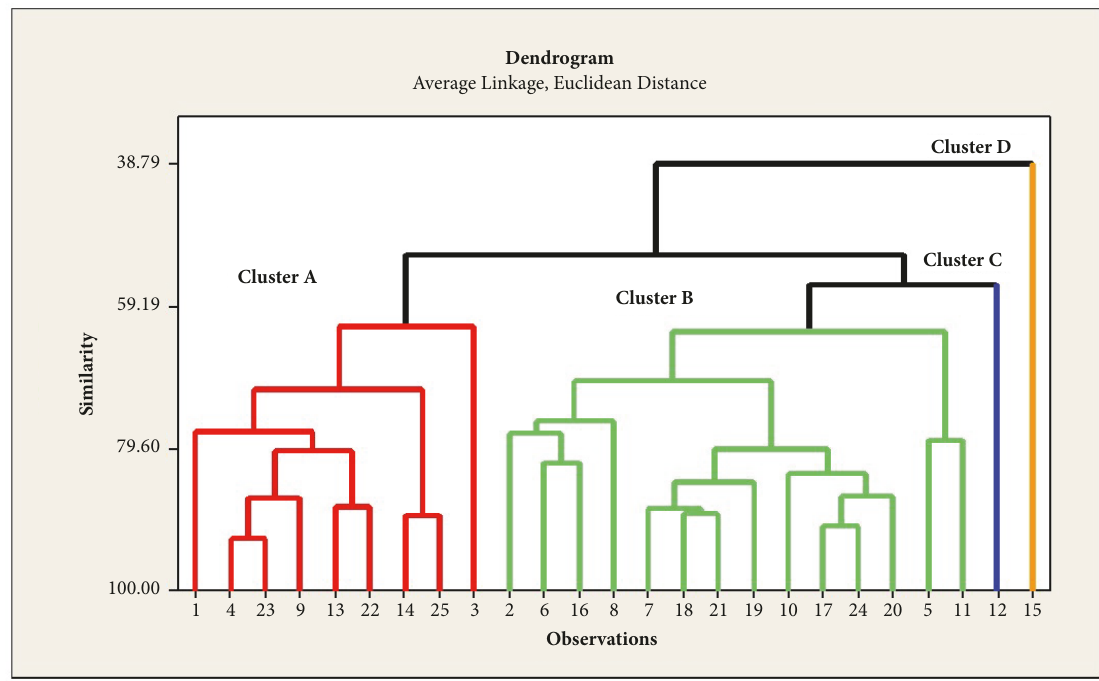
Figure 2: Average linkage-based dendrogram showing hierarchical grouping patterns of 25 sesame accessions (C1-W5) in four clustersbased on 11 major quantitative and qualitative morphophysiological traits. 1=C1, 2=C2, 3=C3, 4=C4, 5=C5, 6=K1, 7=K2, 8=K3, 9=K4, 10=K5, 11=S2, 12=S3, 13=S4, 14=S5, 15=S1. 16=T1, 17=T2, 18=T3, 19=T4, 20=T5, 21=W1, 22=W2, 23=W3, 24=W4,